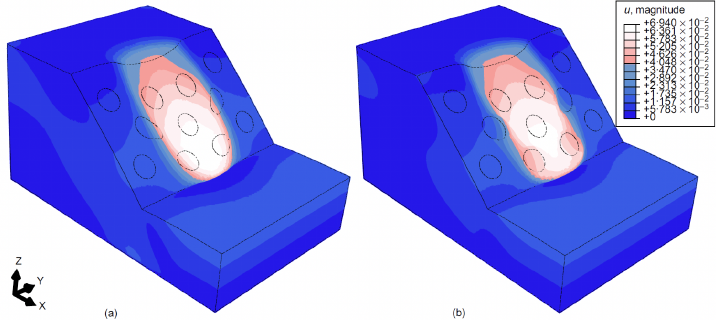
Figure 2. Contours of displacements, obtained at the end of calculations, for the two extreme cases: (a) non-vegetated slope; (b) vegetated slope with both mechanical root reinforcement and evapotranspiration considered. Different shapes of failure surfaces can be observed. Note that the circles are a projection of root zones (values of displacements are given in metres) [4]